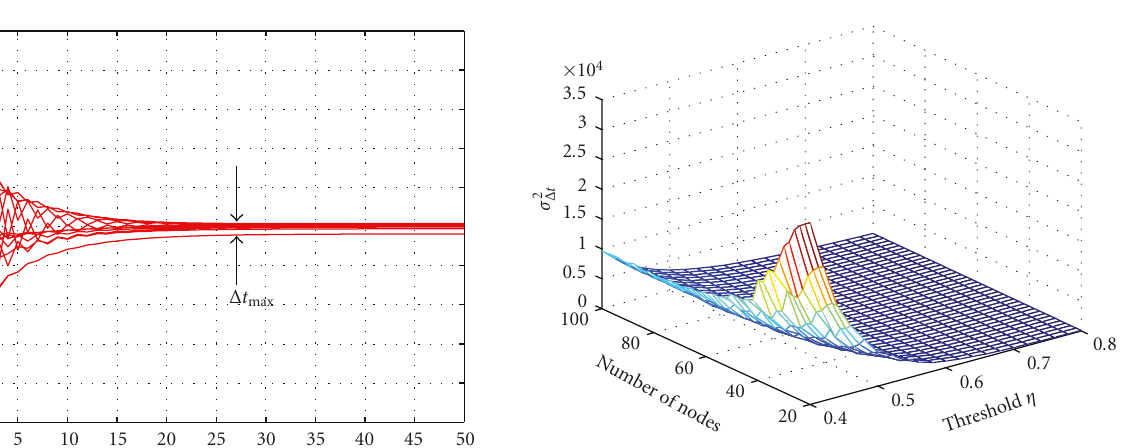
Figure 8: σ 2 as a function of the number of nodes and threshold η Δ t for the DCTS algorithm in random networks with Gaussian delay.